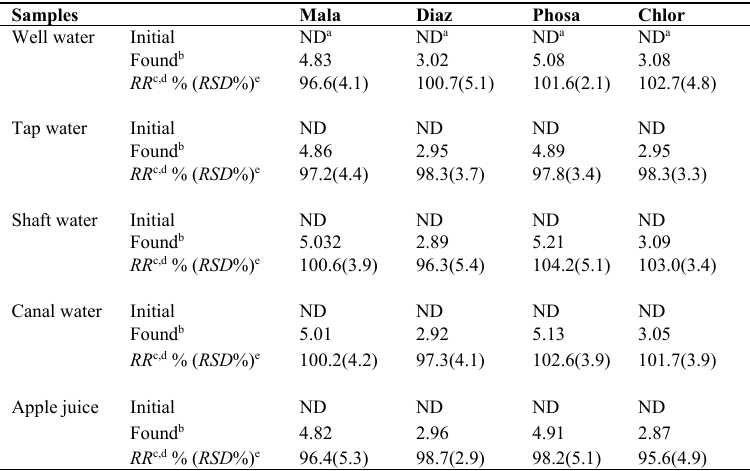
a Not detected.; b Spiked concentrations of Mala, Diaz, Phos and Chlor are 5, 3, 5, 3 ng mL -1 , respectively.; c Relativerecovery.; d Percentage ratio of the found and spiked concentrations; e Obtained for three determinations.